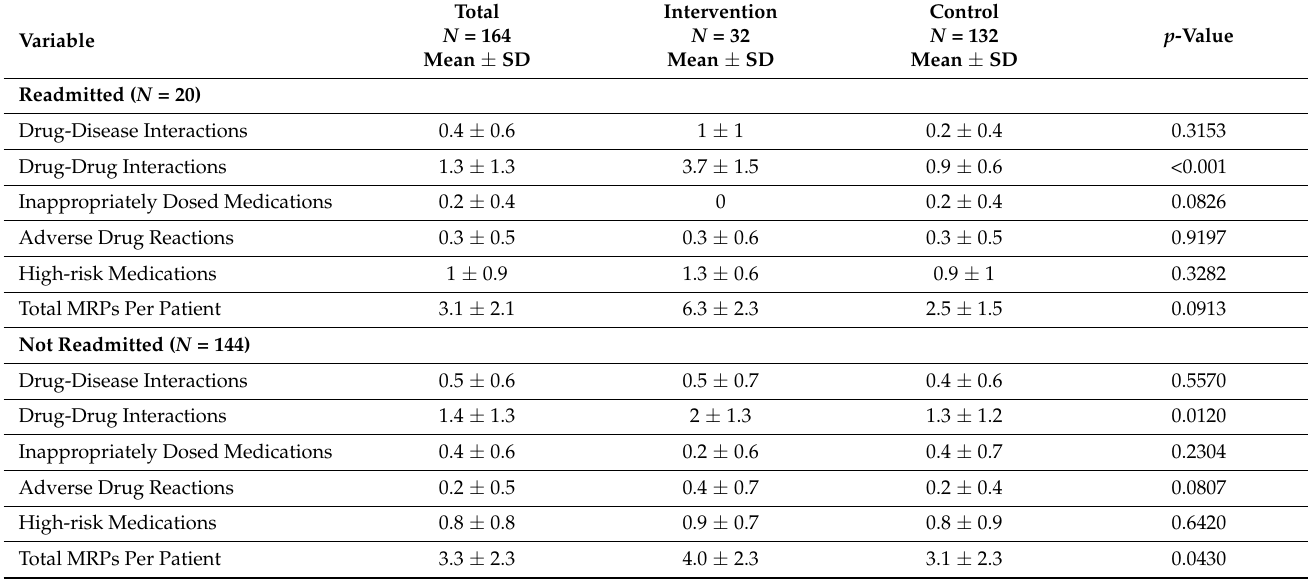
Table 3. Medication safety-related problems identified by the pharmacist per patient.